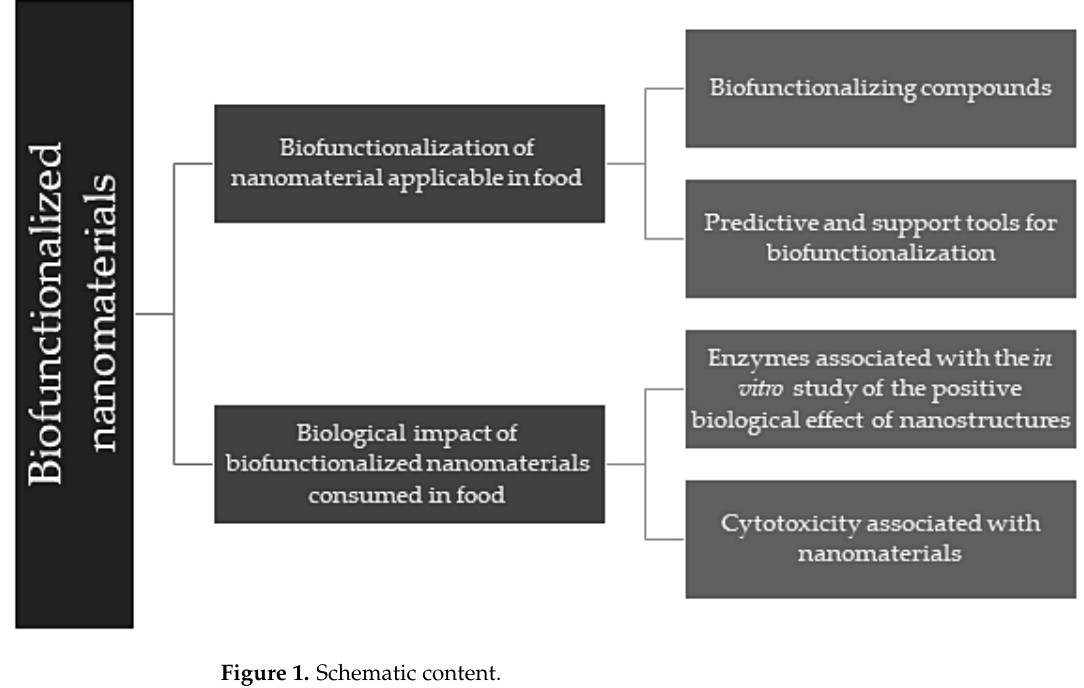
Figure 1. Schematic content.